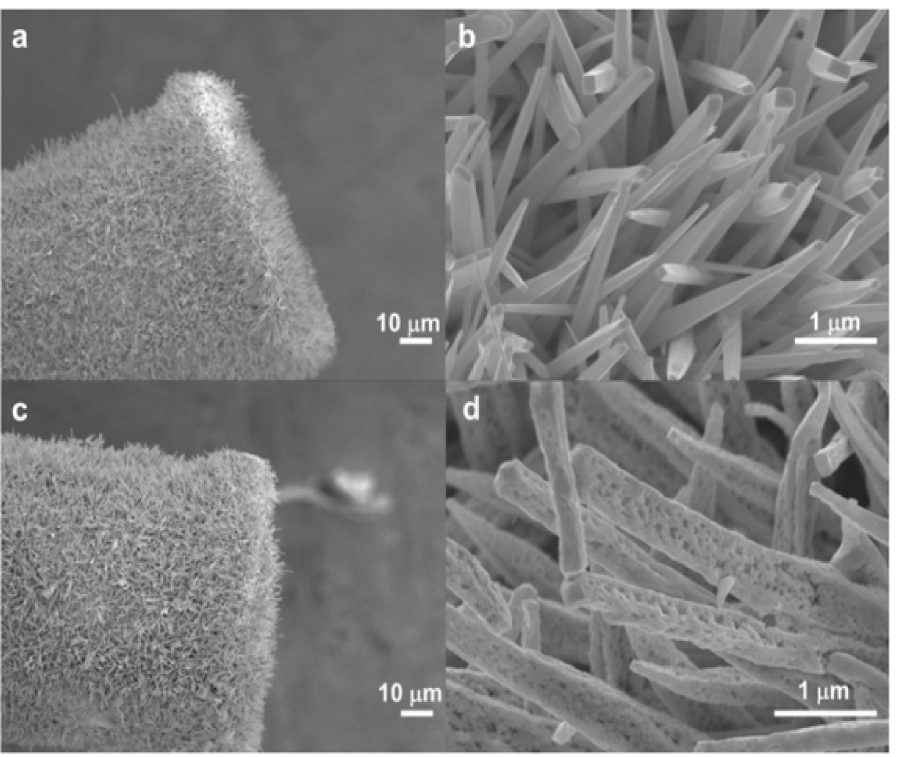
Figure 5. SEM images with different magnifications of ( a , b ) IrO 2 NW ( c , d ) Ir/IrO 2 NW on an Au microwire. Reprinted with permission of reference [28]. Copyright 2015 Elsevier B.V.